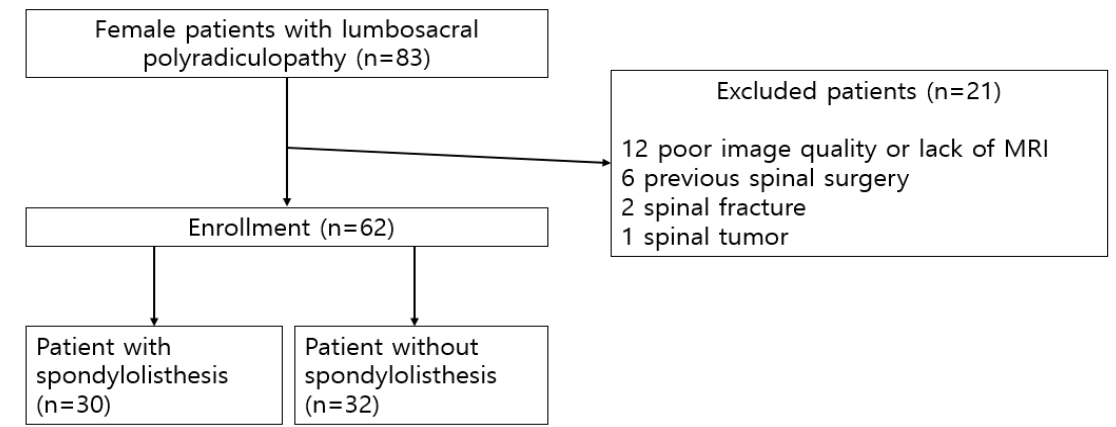
Figure 1. Flow chart of patient enrollment and grouping.